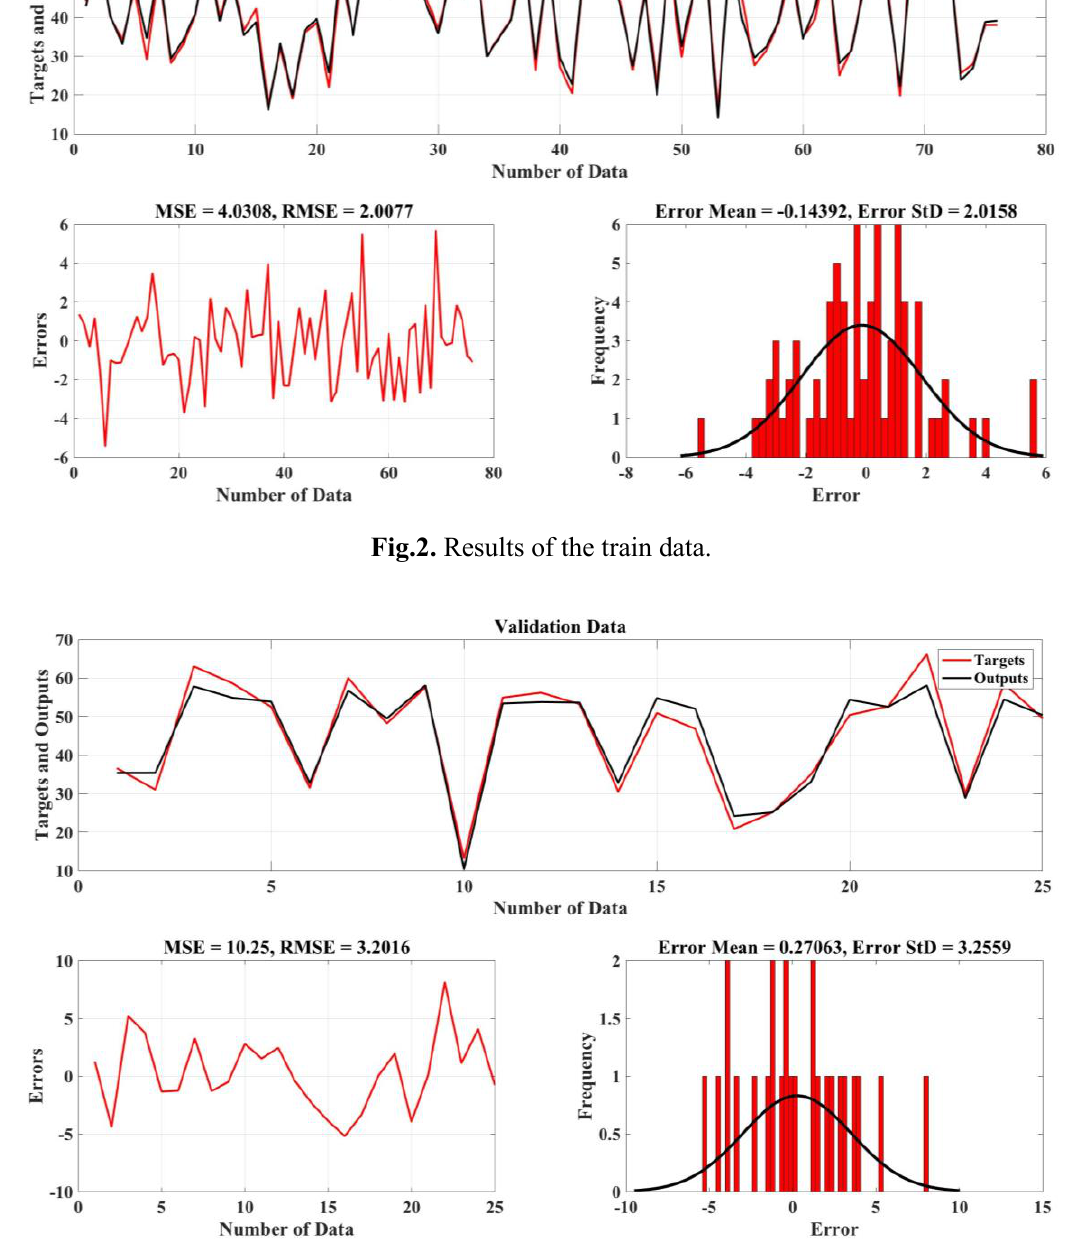
Fig.3. Results of the validation